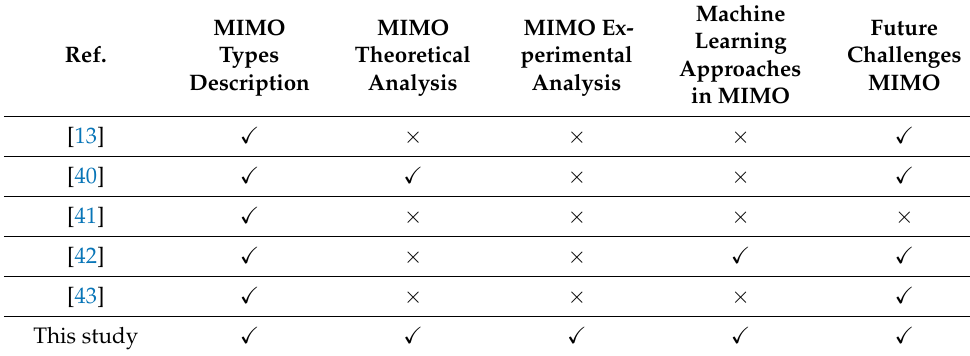
Table 1. Comparison with related studies MIMO VLC.